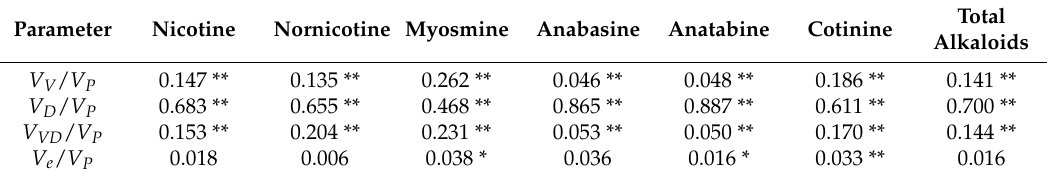
Table 5. Estimated proportions of variance components for alkaloids in Nicotiana tabacum leaves. Parameter